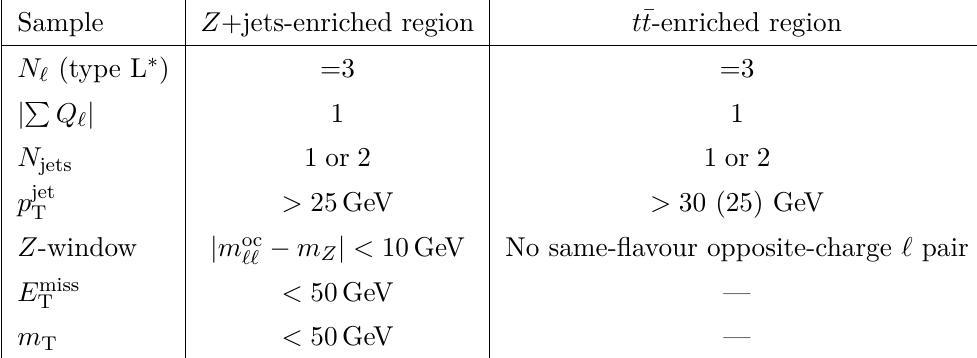
Table 6 . The selection criteria that define the control regions enriched in non-prompt leptons used to determine the MC scale factors for the 4 ‘ channel. The leptons are required to pass the loose and minimally isolated (L ∗ ) requirements. The transverse mass, m mass of the vector sum of the transverse momentum of the non-prompt-lepton candidate and the missing transverse momentum. The symbol “—” means no requirement is made. The equal sign (=) is used to emphasise that the selection criterion has to be exactly the given